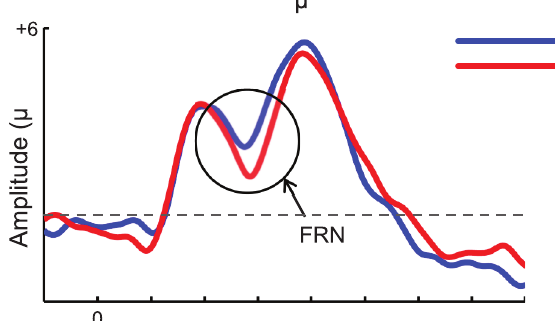
Figure 5. P3 data. Figure 5a. Averaged ERP waveforms for the Feedback-related P3 plotting ERPs to Wins and Losses separately for the four experimental conditions. Figure 5b. Topographical maps plotting difference scores between peak-to-peak amplitudes of Win minus Loss ERPs between 250 and 350 ms (maxima: + 1.0 m V, minima: 2 3.5 m V). Figure 5c. Scalp location of cluster of electrodes used to quantify the FRN.